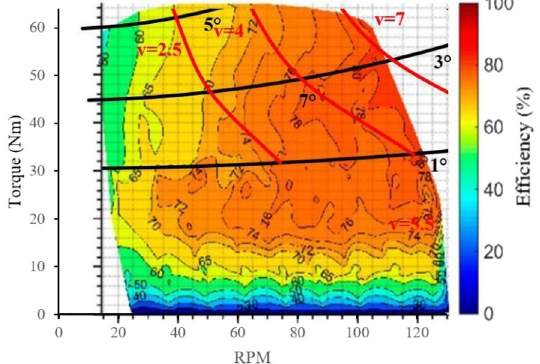
Fig. 16 PU efficiency map with overlaid iso-speed (red) and iso- gear curves (black). Steady-state drive on a 2% sloped road